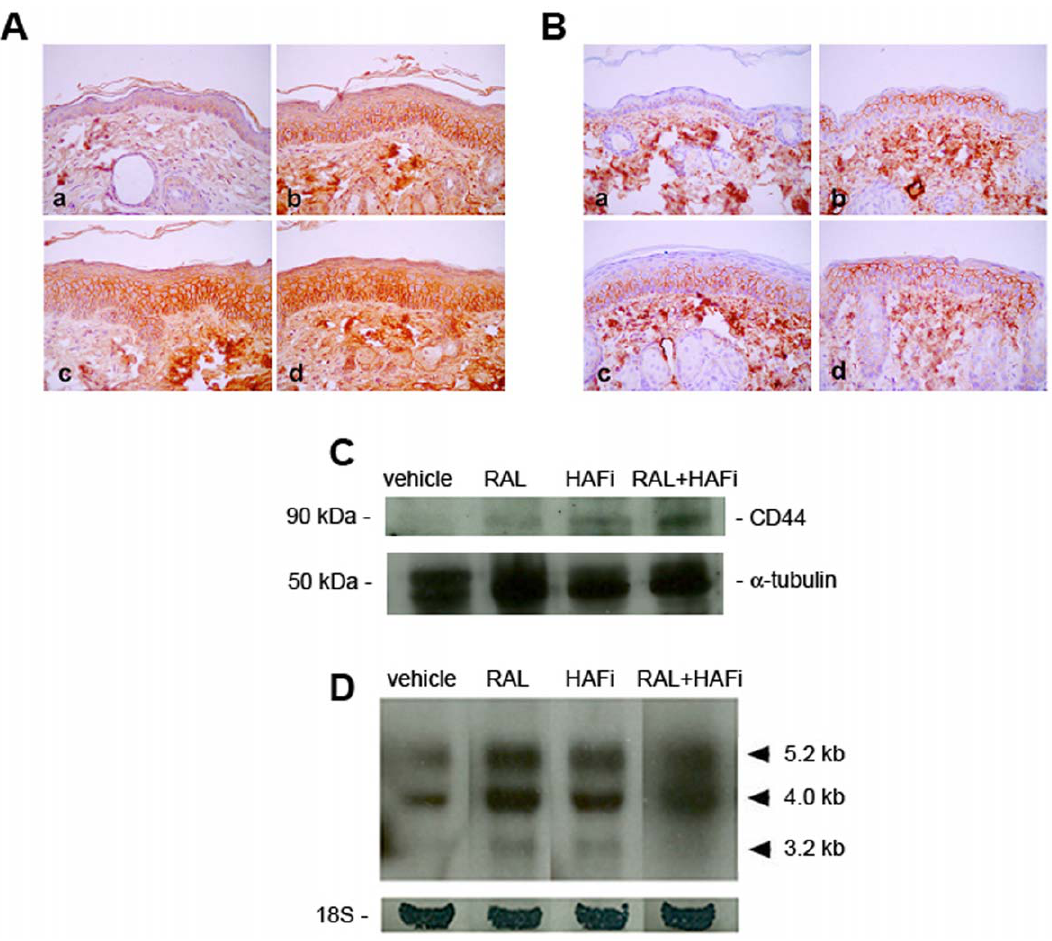
Figure 3. RAL and HAFi have a synergistic effect on the protein and mRNA expression of CD44 in mouse skin. A. Immunostaining of sections of vehicle- (a), RAL- (b), HAFi- (c) or RAL- and HAFi- (d) treated DBA/1 mouse dorsal skin with anti-CD44 antibodies. Note the hyperplasia and increase in diffuse CD44 expression in the epidermis in RAL-, HAFi- and RAL- and HAFi-treated mice. B. Immunostaining of sections of vehicle- (a), RAL- (b), HAFi- (c) or RAL- and HAFi- (d) treated DBA/1 mouse dorsal skin with anti-CD44v3 antibodies. Note the hyperplasia and increase